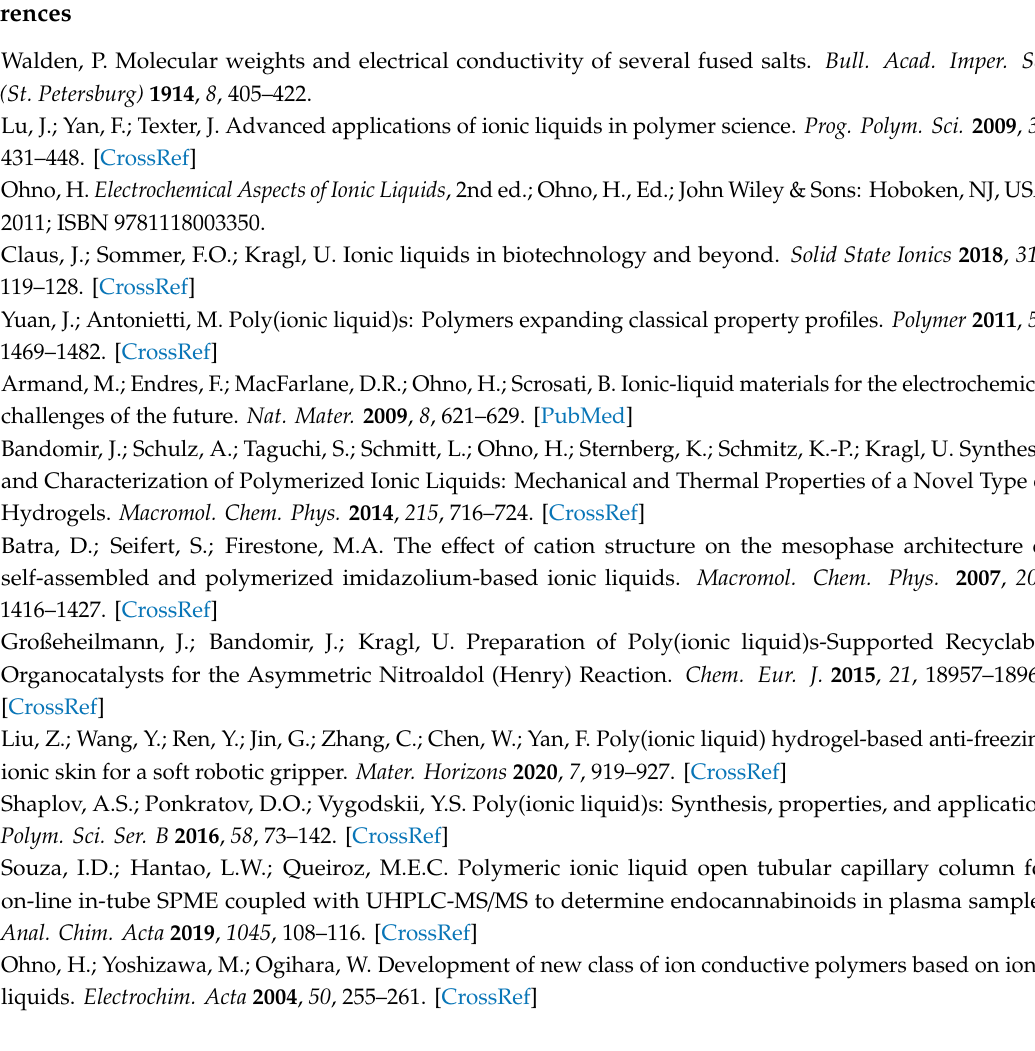
Figure S1: title, Table S1: title, Video S1: title. The synthesis and purity of ionic liquids were verified by NMR and melting point measurements. Figure S1. Pictures of (un-)successful layer formations with di ff erent; Figure S2. Aqueous flux measurement of synthesized and commercial membranes; Figure S1: Retentate, filtrate and retention in dead-end (0–270 h) and diafiltration experiments (270–590 h) with calcium gluconate using PILs BD2; Figure S4. Retentate, filtrate and retention in dead-end filtration with d -glucose using PILs BD2; Figure S5. Retentate, filtrate and retention in dead-end filtration with sucrose using PILs BD2; Figure S6. Retentate, filtrate and retention in dead-end filtration with ra ffi nose using PILs BD2; Figure S7. Retentate, filtrate and retention in dead-end filtration with d -mannitol using PILs